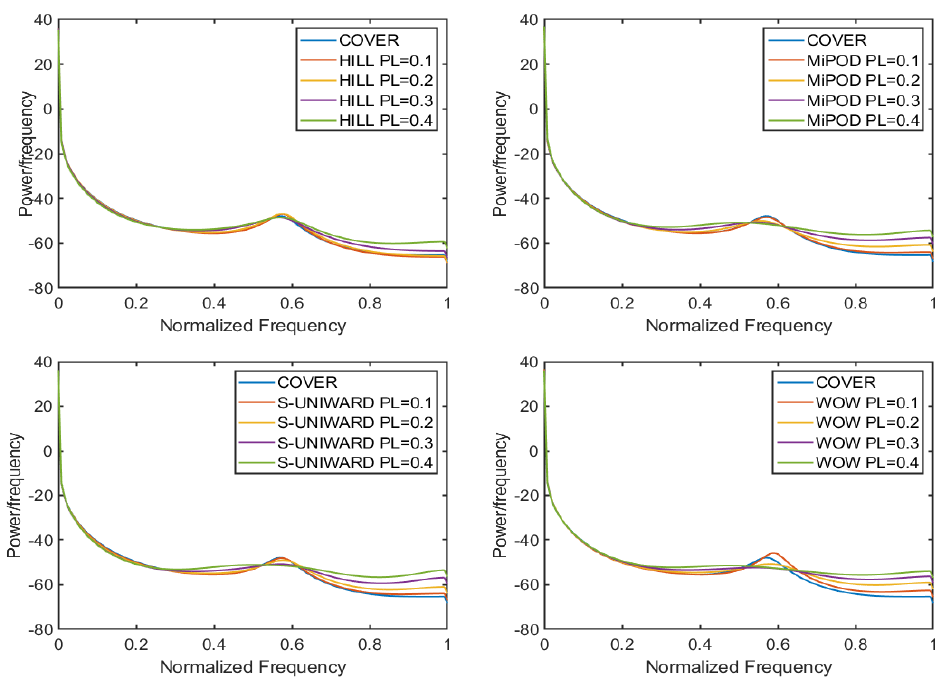
Figure 3. Covariance plots of cover and stego images entropy.